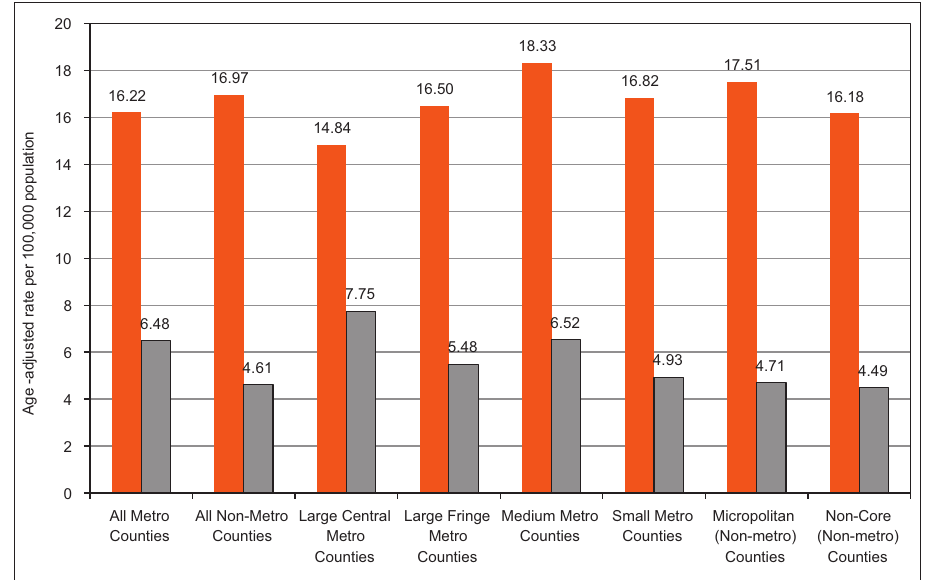
Fig ure 23. Age-adjusted Drug Overdose Mortality Rate per 100,000 Population by Urbanization Level, United States, 2000 and 2015 Source: CDC/NCHS. Data derived from the National Vital Statistics